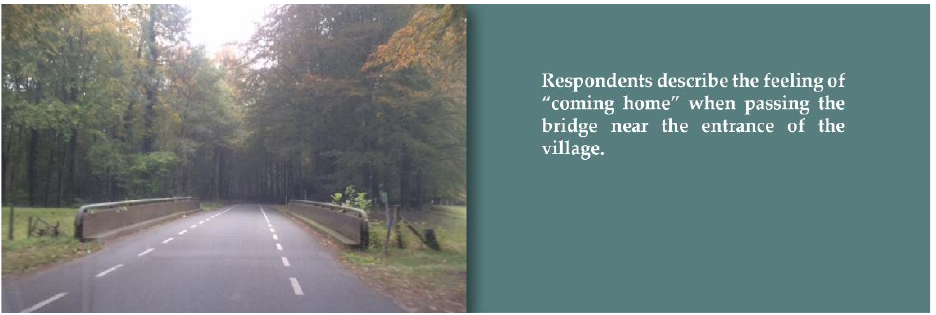
Figure 4. Entrance to the village. Source: photo submitted by a participant for the photovoice study.